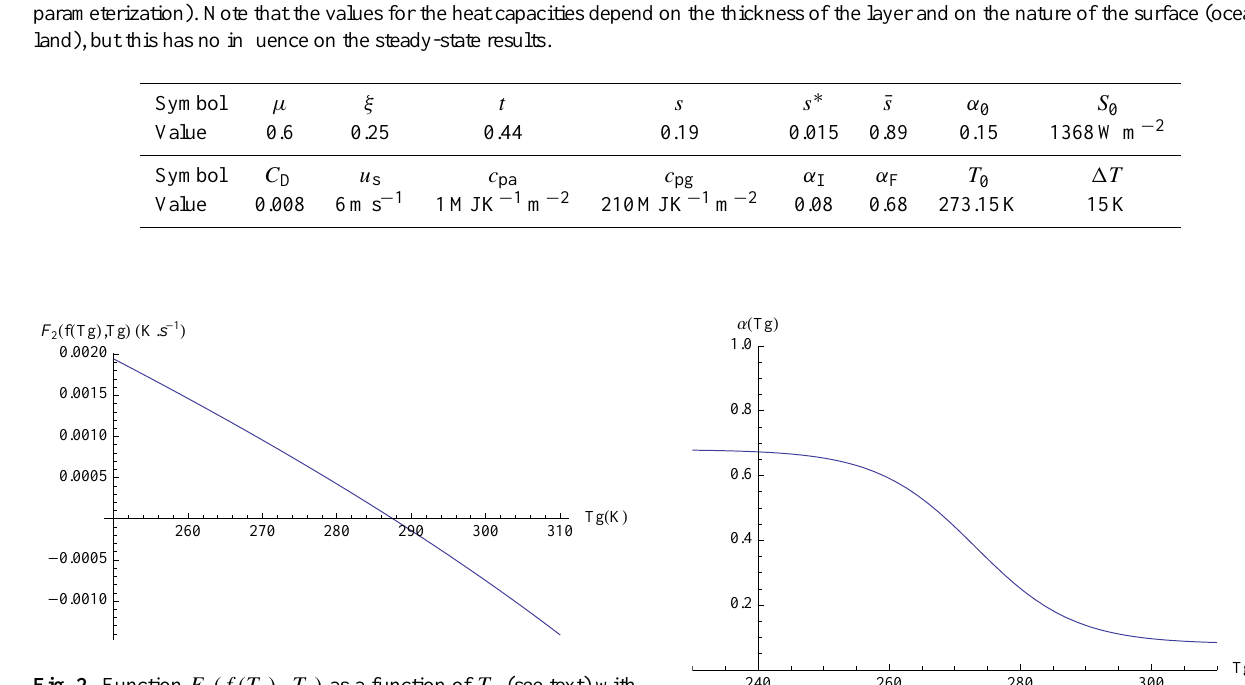
Fig. 2. Function F 2 (f (T g ), T g ) as a function of T g (see text) with a fixed albedo has only one root.